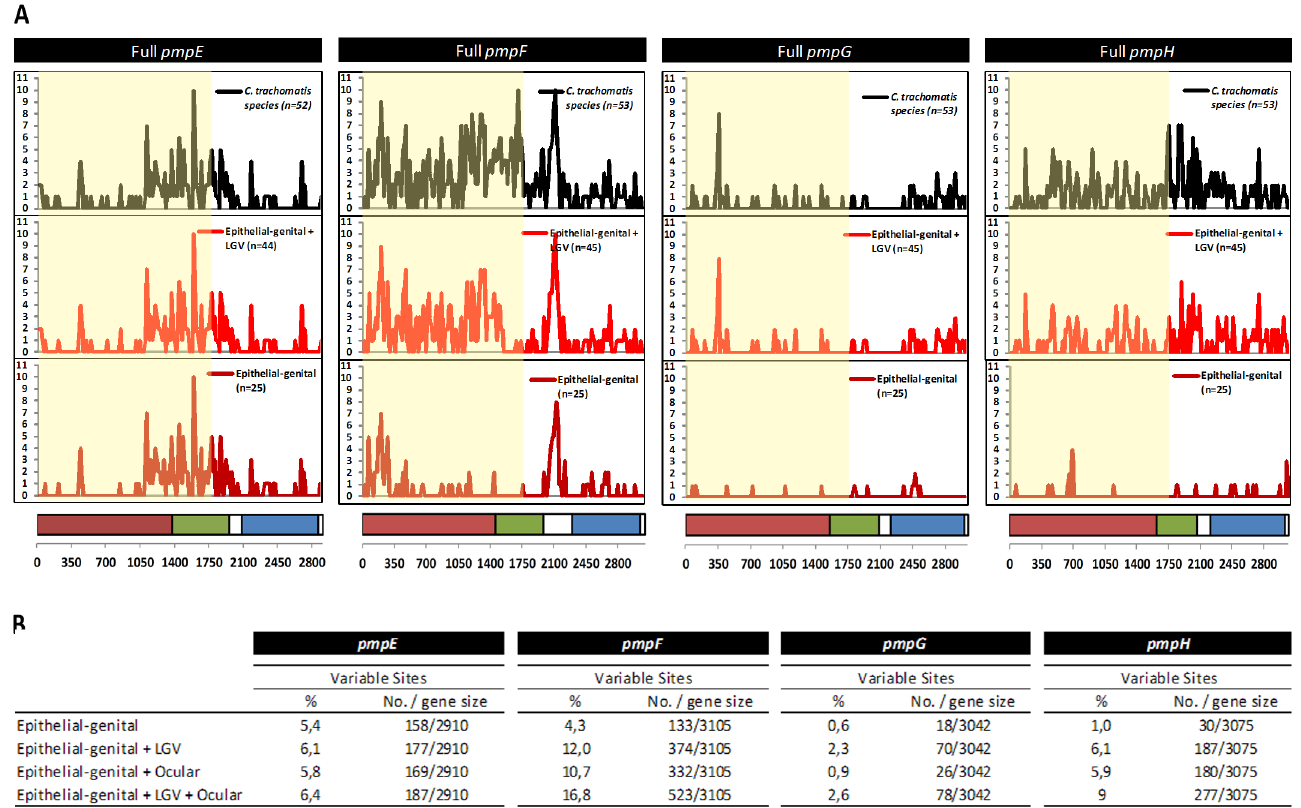
Fig 1. Global polymorphism analysis. A) Sliding-window analysis of the genetic variability throughout each pmp (window and step size of 15 bp). For each pmp , the black plot represents the polymorphism among all strain collection, while the remainder plots represent the impact of removing strains from the ocular group (red plot) and from the LGV group (magenta plot) on the global polymorphism. The region highlighted in yellow encompasses the 1 st 600 amino acids (used in vaccine attempts) where further analyses were performed. The horizontal bars below the plots represent the typical domains of these autotransporter proteins: passenger domain (magenta), middle domain (green), and C-terminal autotransporter domain (blue). B) Impact in both the number and percentage of variable sites found among C . trachomatis strains after the successive addition of LGV and ocular strains to the epithelial-genital group.